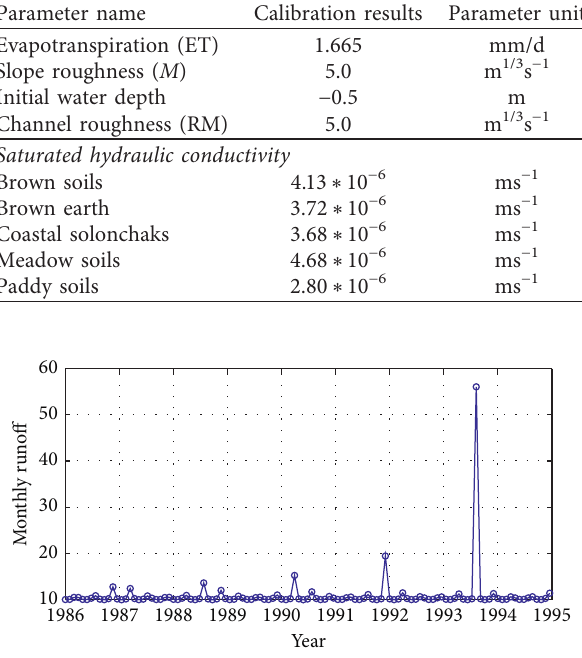
Figure 6: Simulation results of monthly runoff in Jianchang field (1986 ∼ 1995).